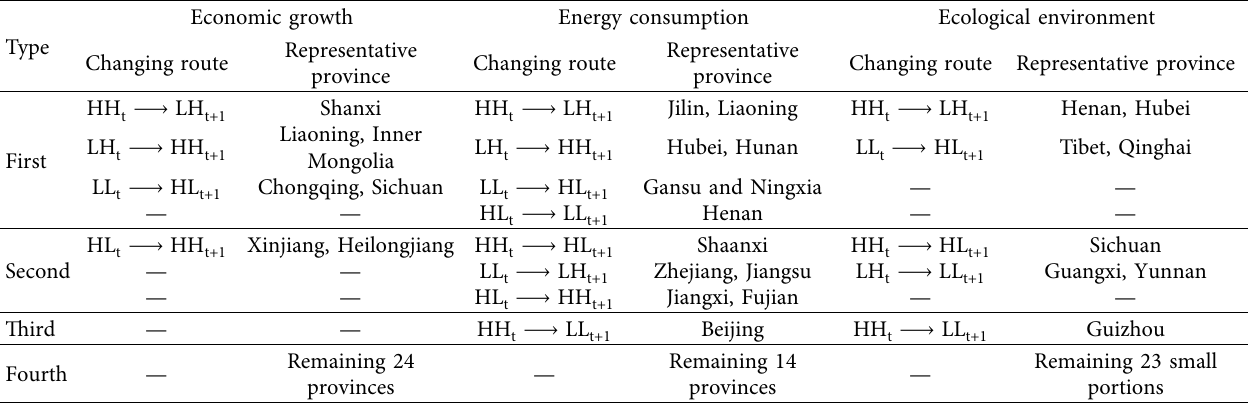
Table 5: Economic growth, energy consumption, and ecological environment space transition of the Moran scatterplot (2008–2019).